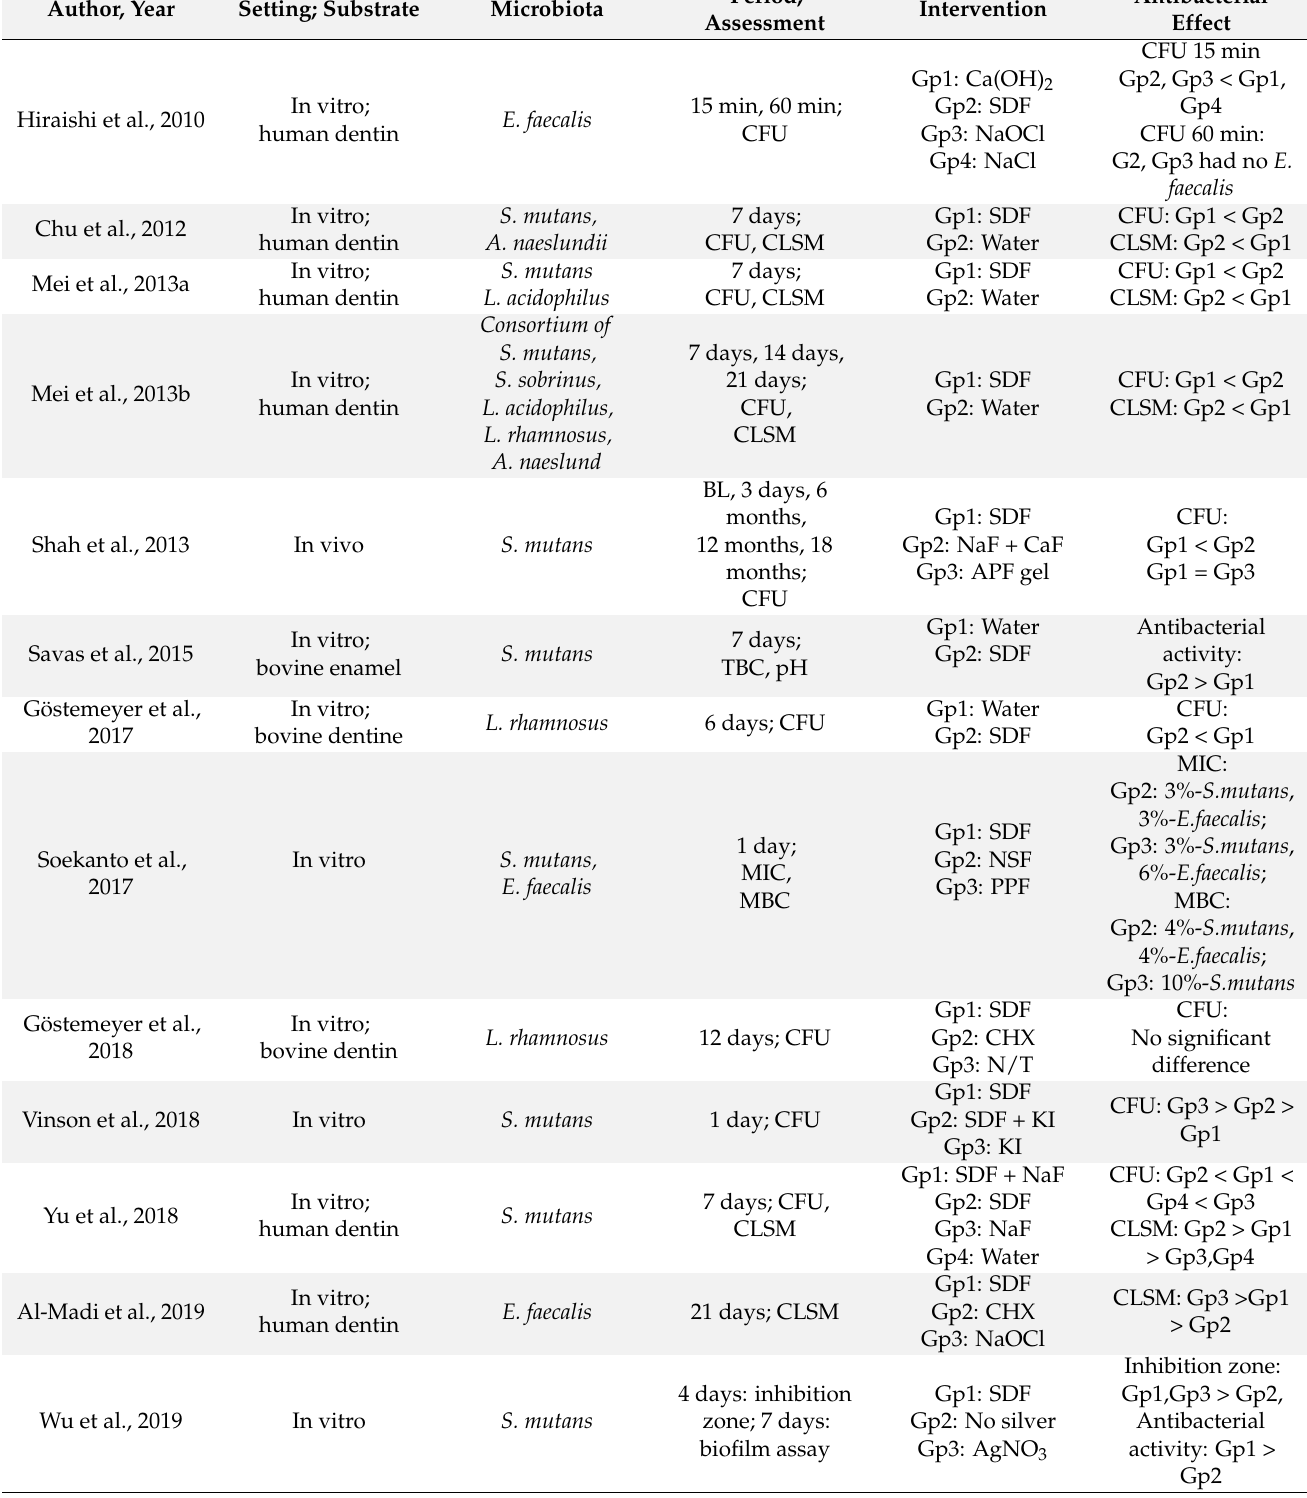
Table 1. Studies on the antibacterial effect of silver diamine fluoride